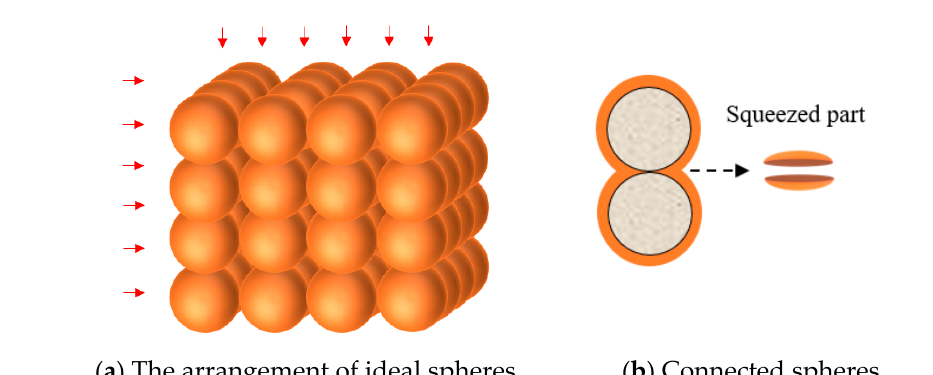
Figure 16. Structural model of RPOC.